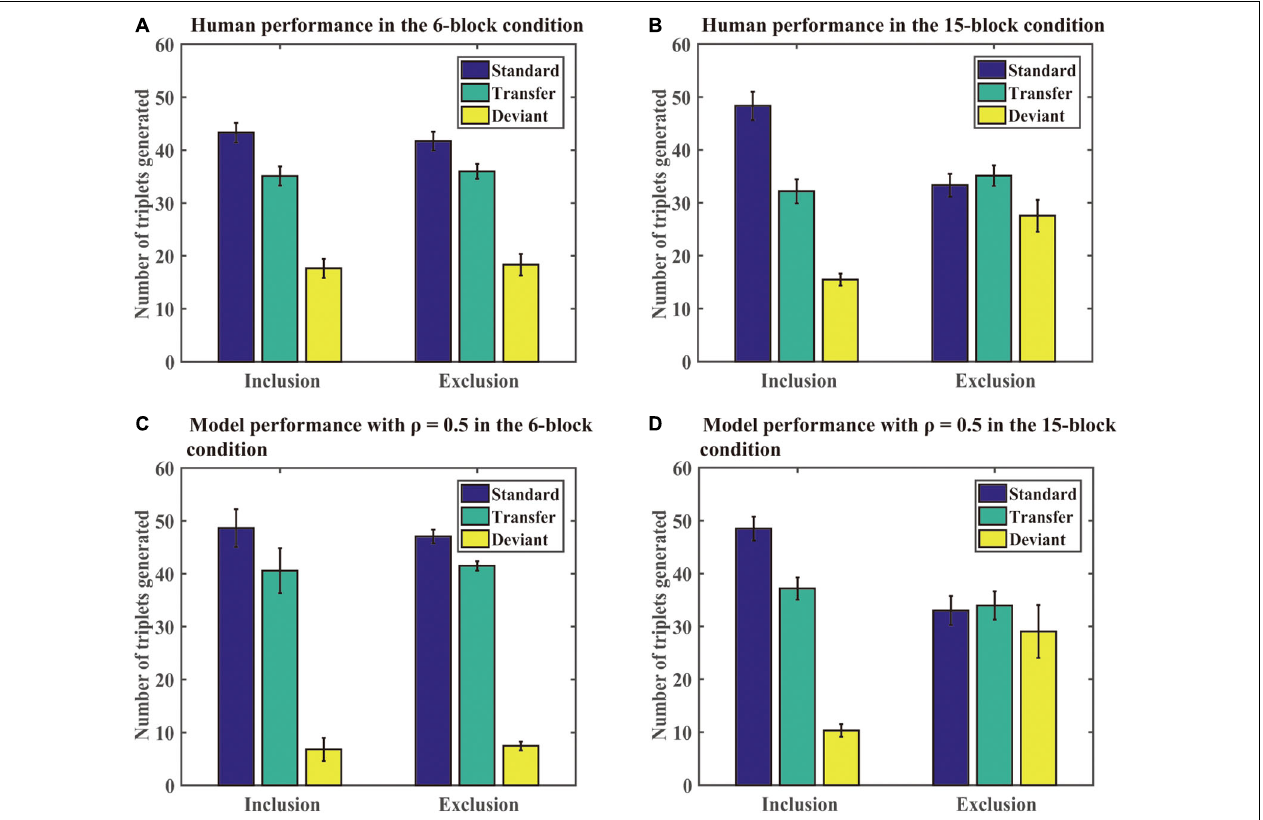
FIGURE 6 | Human and model performance under inclusion and exclusion tests in Simulation 2. (A) The number of triplets generated by human participants in the 6-block condition. (B) The number of triplets generated by human participants in the 15-block condition. (C) The number of triplets generated by DSRN models in the 6-block condition. (D) The number of triplets generated by models in the 15-block condition.